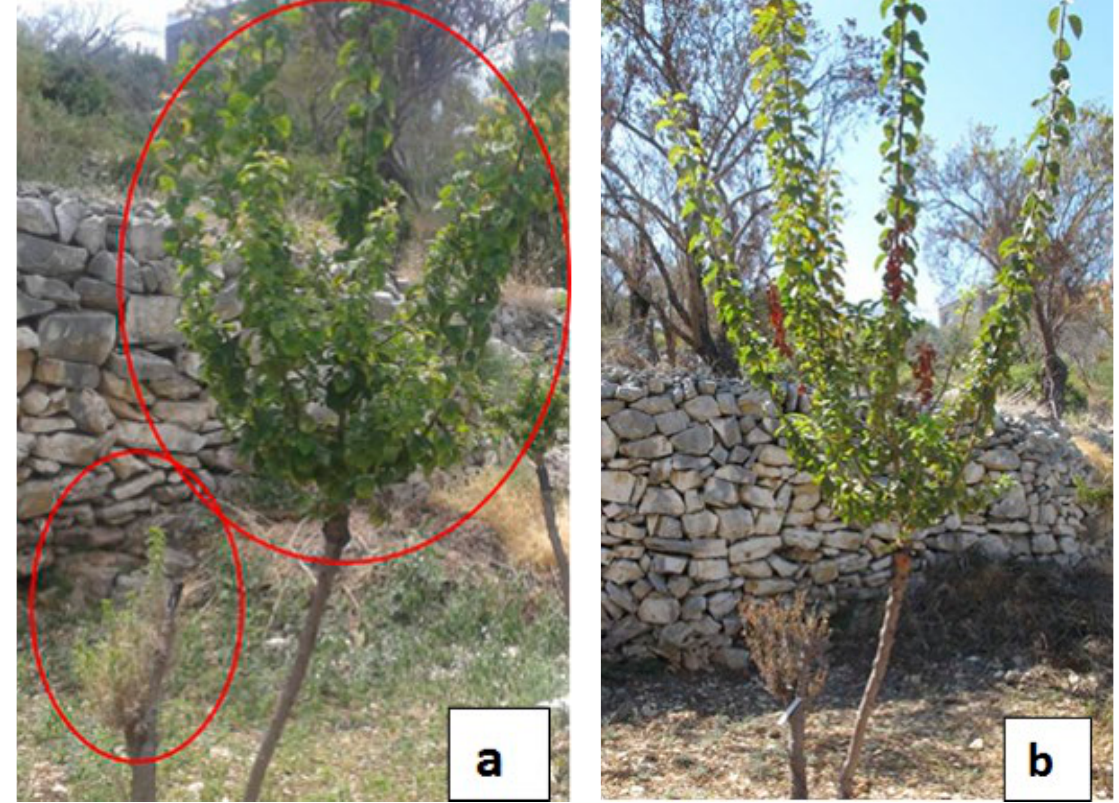
Figure 2. Two branches of the same tree, one showing almond growth (bottom left) and one showing Janarek plum growth (top right); photos taken in June (a) and in September (b),